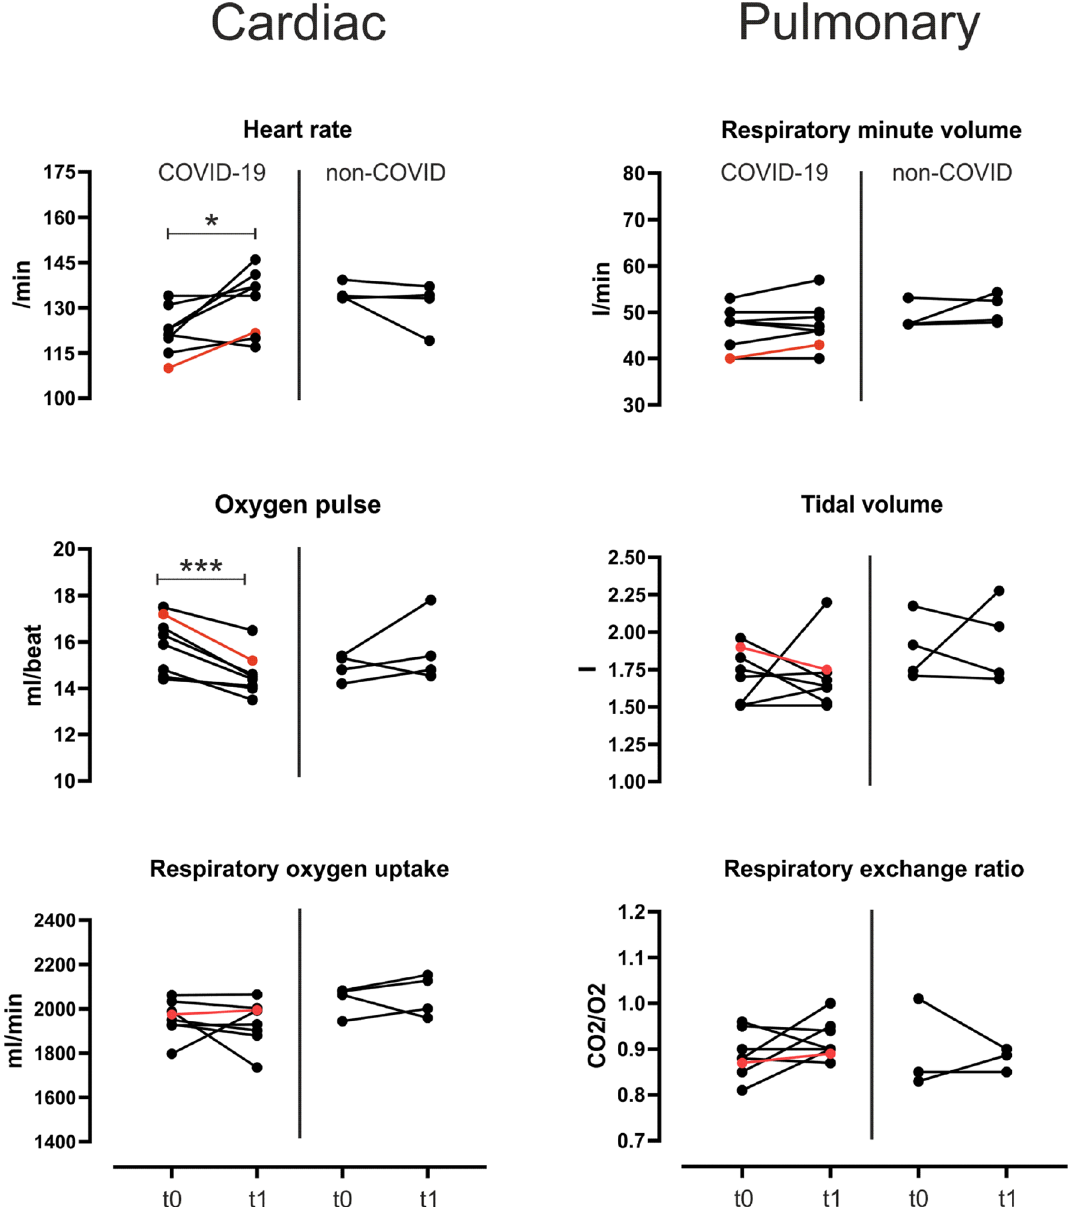
Figure 3. Mean values of cardiac and pulmonary parameters under moderate intensity in a CPET (100–200 Watt) in athletes with or without a history of SARS-CoV-2 infection. t0: Routine CPET during preparation phase in summer 2020 t1: post-SARS-CoV-2 infection (COVID-19) in winter 2020 or during other cardiac outpatient diagnostics in winter 2020 (non-COVID). The athlete with the highest T1-mapping values in magnetic resonance imaging and with pericardial effusion during the infection is highlighted in red. *: p < 0.05; ***: p <